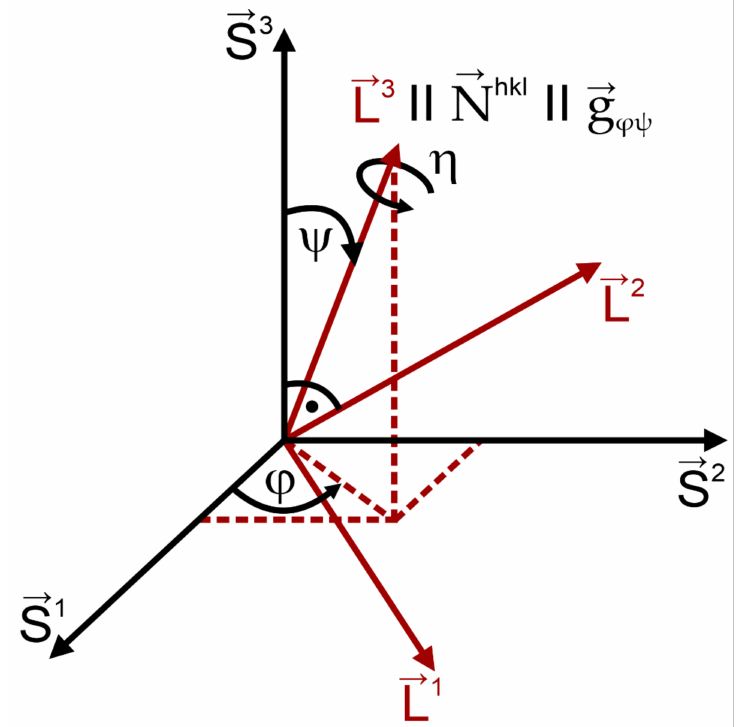
Figure 5. Orientation of the laboratory coordinate system (L) with respect to the sample coordinate system (S), and the associated angles ϕ and ψ . η denotes the rotation angle around the measurement direction (adapted from